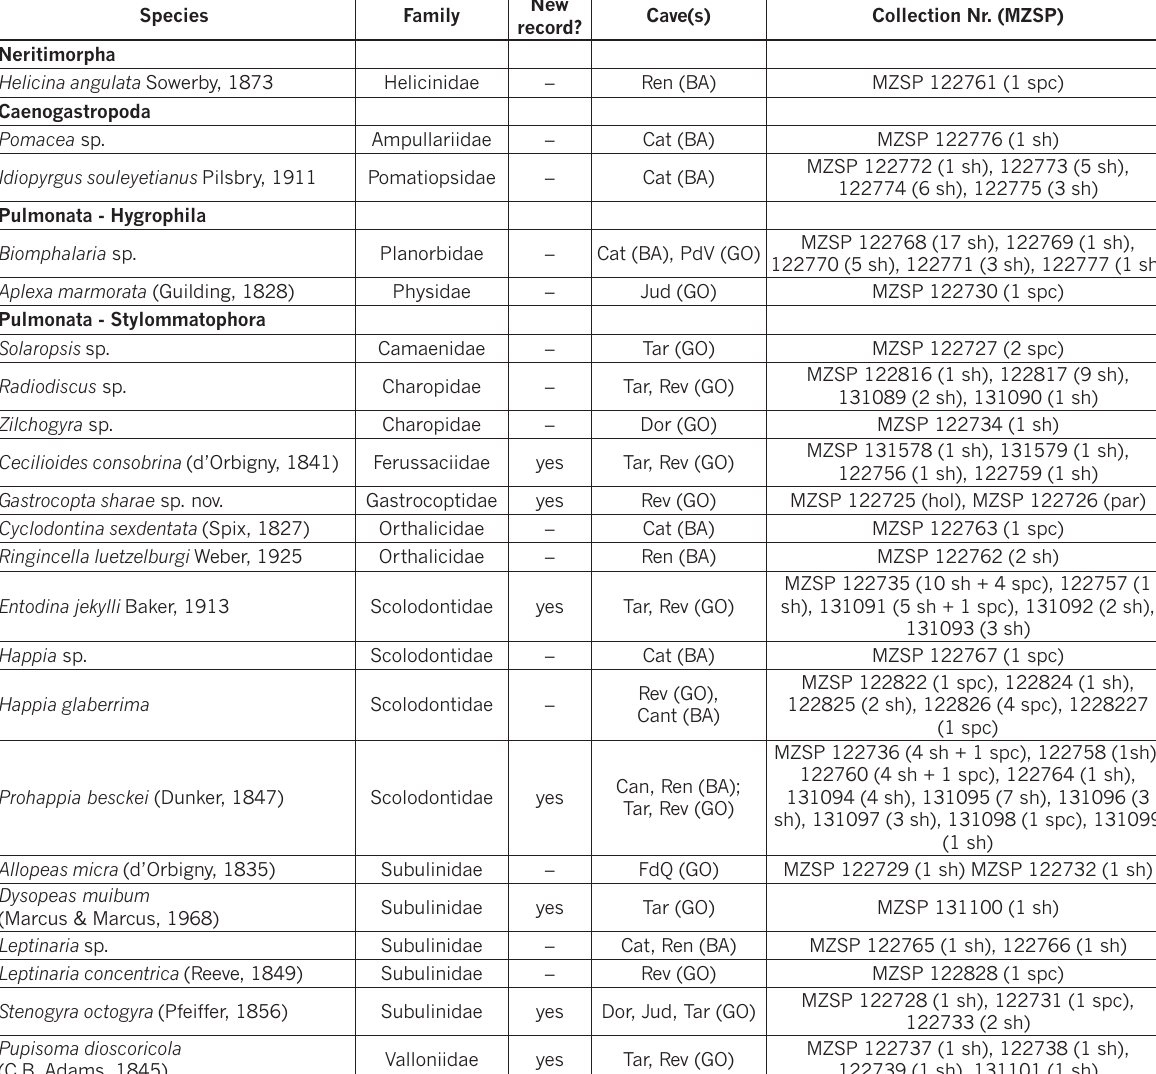
Table 2. List of all species found on the present material, with information on locality data, whether it is a new occurrence (species with new records are analyzed more thoroughly in the text) and record number of the MZSP collection. Abbreviations: BA, Bahia state; GO, Goiás state; Can, Gruta Cantinho; Cat, Gruta do Catão; Dor, Gruta das Dores; FdQ, Gruta Fundo de Quintal; Jud, Gruta Judite; PdV , Pasto de Vacas I; Ren, Gruta do Renatão; Rev, Gruta Revolucionários; Tar, Gruta da Tarimba; hol, holotype; par, paratype; sh, shell; spc,